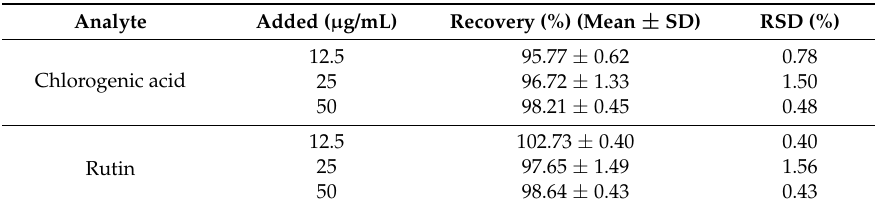
Table 4. Analytical recovery data ( n = 6).